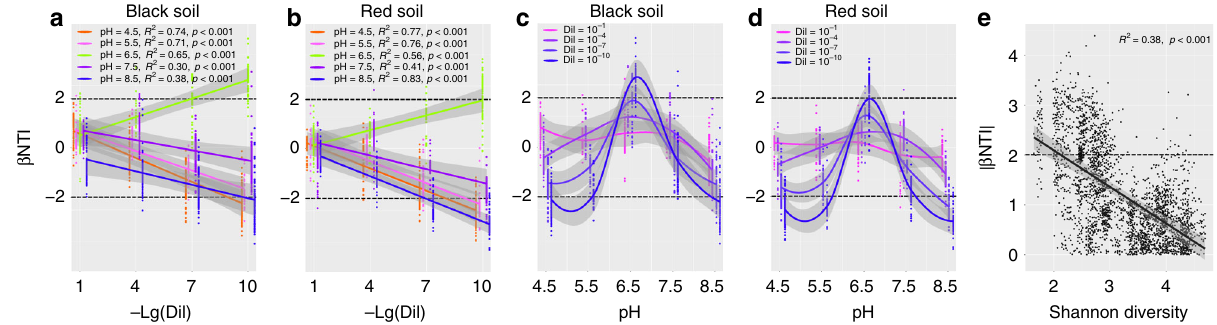
Fig. 3 β NTI values are associated with dilution and pH levels, and bacterial Shannon diversity. a The relationships between − Lg(Dil) and β NTI in black soil. b The relationships between − Lg(Dil) and β NTI in red soil. c The effect of soil pH on β NTI in black soil. d The effect of soil pH on β NTI in red soil. e The relationship between | β NTI| and bacterial Shannon diversity indices. Dil indicates the dilution level. Lg(Dil) indicates the Lg-transformed dilution level. Lg (Dil) = 0 represents the untreated